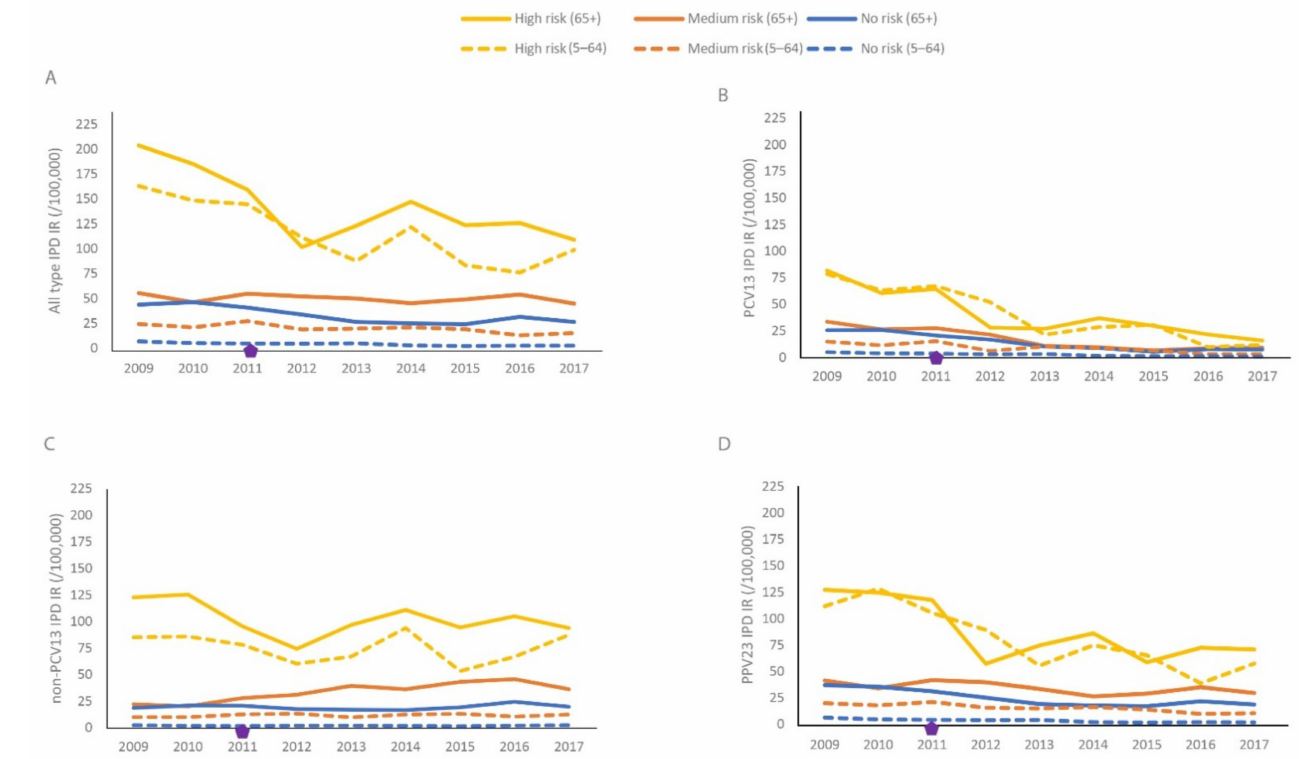
Figure 2. IPD incidence rate by medical risk strata, by age (5–64 and ≥ 65 years). ( A ) All types of IPD, ( B ) PCV13 IPD, ( C ) non-PCV13 IPD, ( D ) PPV23 IPD. Diamonds indicate the year of PCV13 vaccine introduction (2011: PCV13). The three risk groups are mutually exclusive, with the highest risk condition determining the risk group. All types of IPD includes IPD caused by any serotype. PCV13 IPD includes serotypes 1, 3, 4, 5, 6A, 6B, 7F, 9V, 14, 18C, 19A, 19F and 23F; non-PCV13 IPD includes serotypes not included in PCV13; PPV23 IPD includes serotypes included in PCV13 except serotype 6A and serotypes 2, 8, 9N, 10A, 11A, 12F, 15B, 17F, 20, 22F and